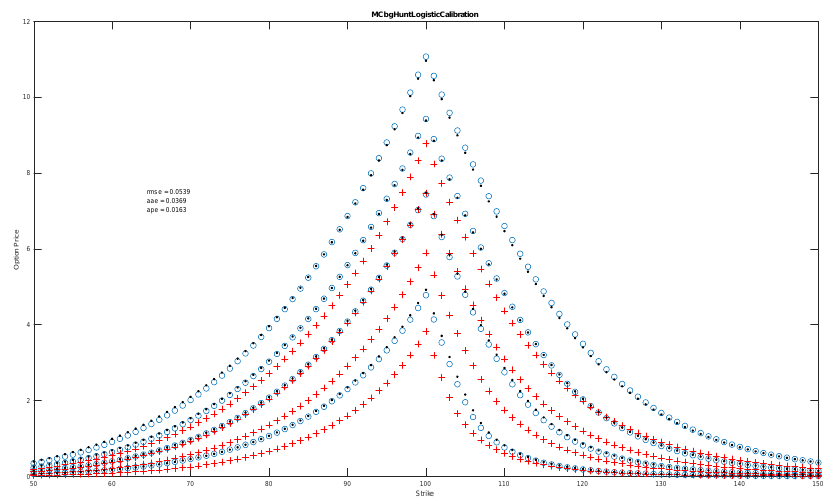
Figure 7. Presented by circles are the stylized true values. The plus signs present model prices evaluated at the starting values. The dots are the result of the calibration using an approximating Markov chain with a single transition rate matrix. Table 4. Fitted Dependence of Parameters on the level of moneyness.